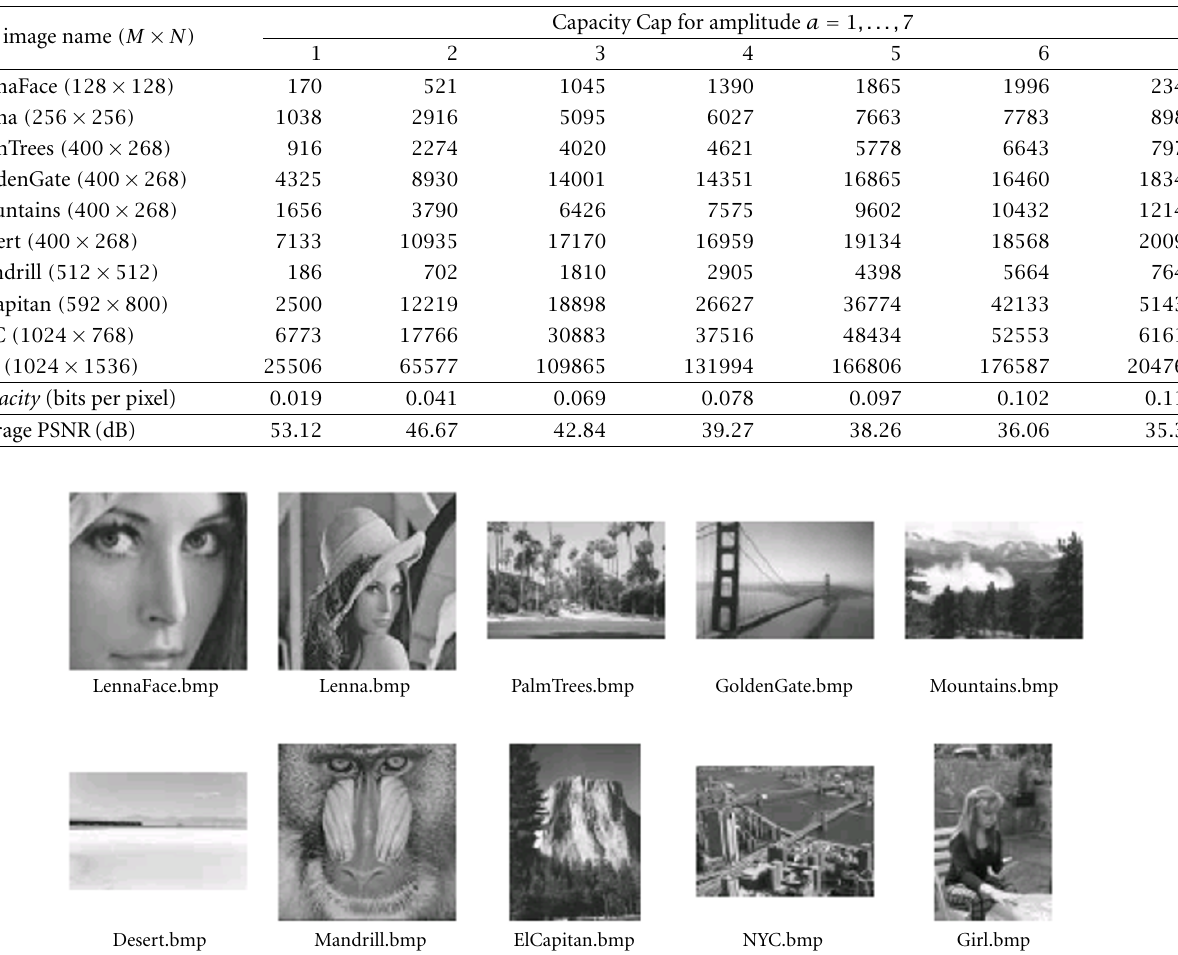
Table 1: Capacity Cap for ten grayscale test images as a function of the amplitude a .